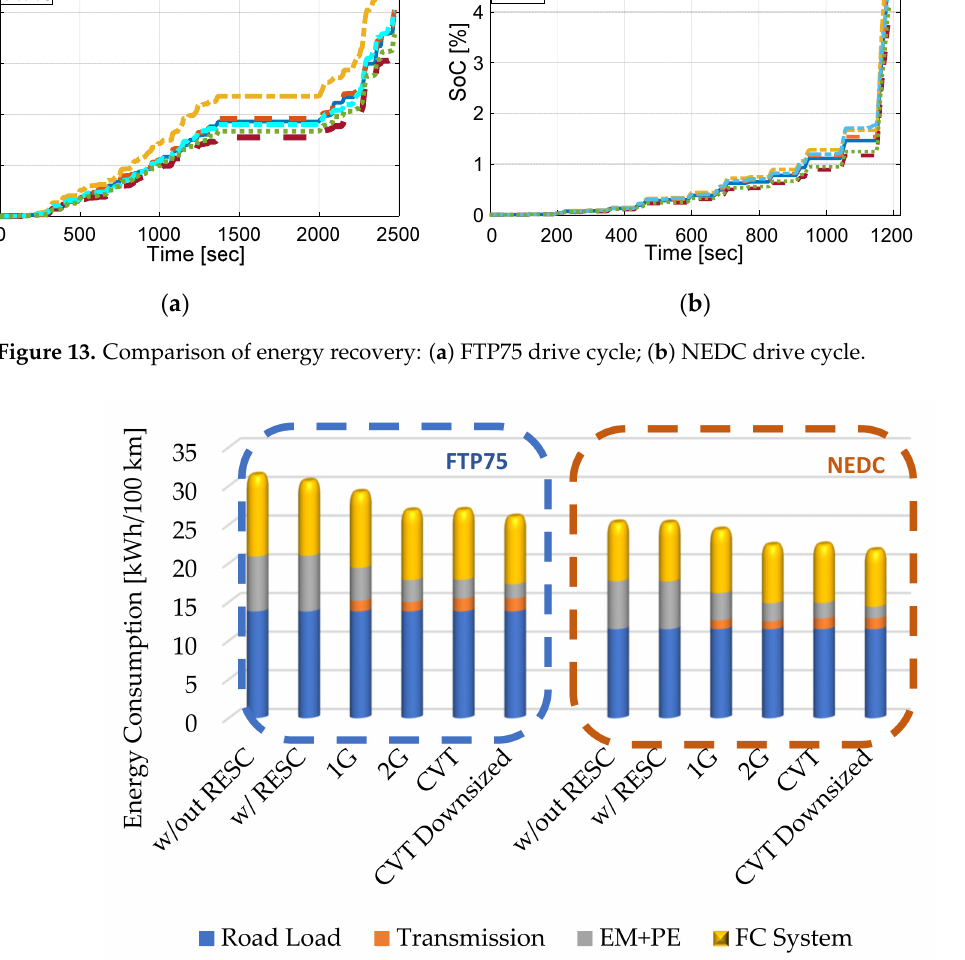
Figure 14. Energy consumption rates per 100 km for FTP75 and NEDC.